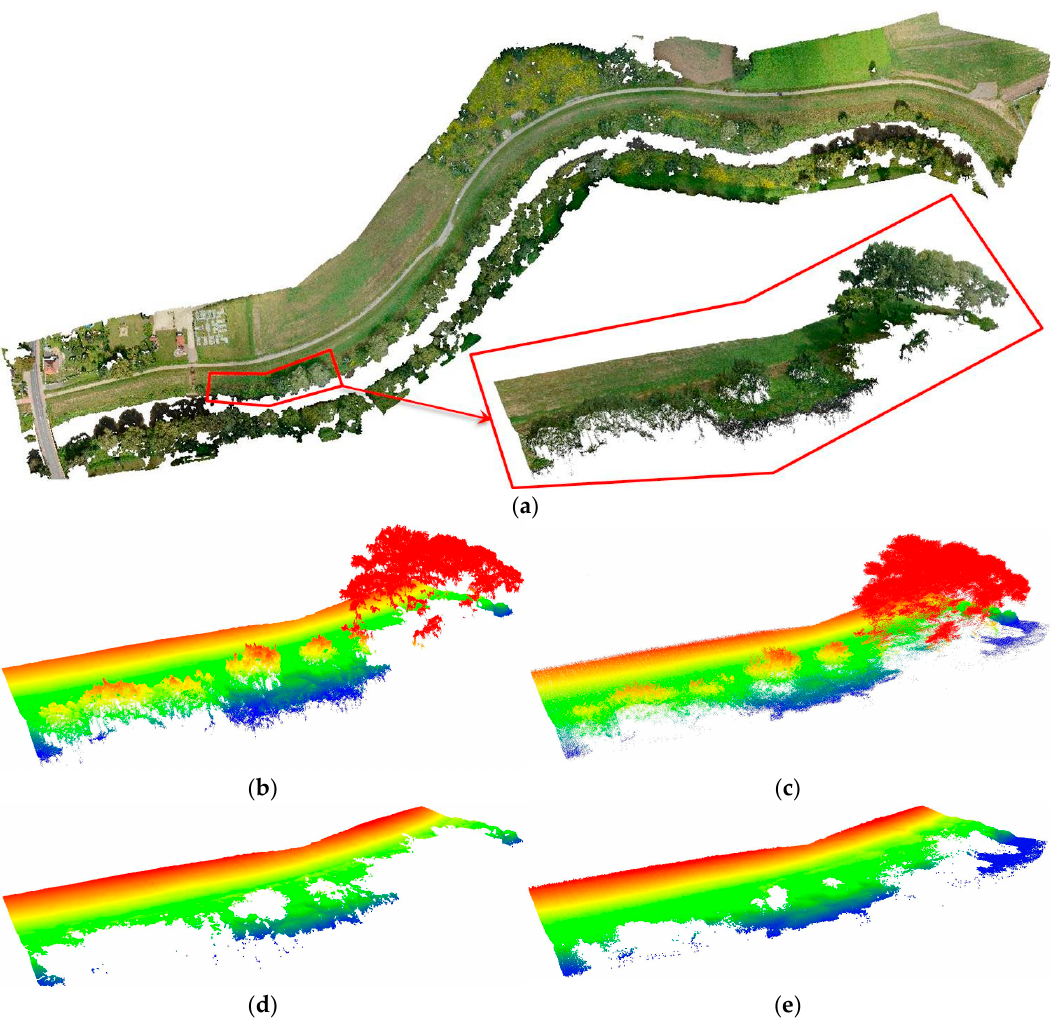
Figure 6. Point clouds collected for a densely vegetated riverbank: ( a ) the location of the sample on the Embankment site, ( b ) the raw point cloud created from RGB images, ( c ) the raw LiDAR point cloud, ( d ) the ground point extracted from a raw RGB image point cloud, and ( e ) the ground points extracted from a raw LiDAR point cloud. For Figure 6b–e, the heights are coded with colors.